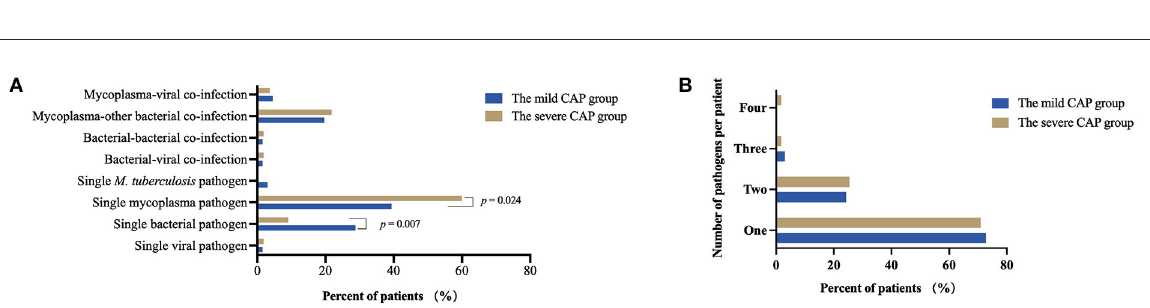
FIGURE7 Common combinations of single pathogen infection and co-infection (A) and total number of pathogens per patient (B) between the mild CAP and severe CAP groups. CAP, community-acquired